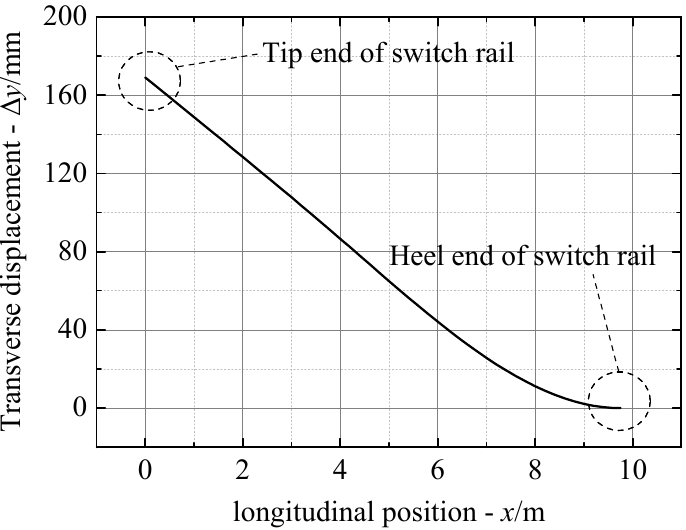
Figure 4. Turnout switching simulation model.